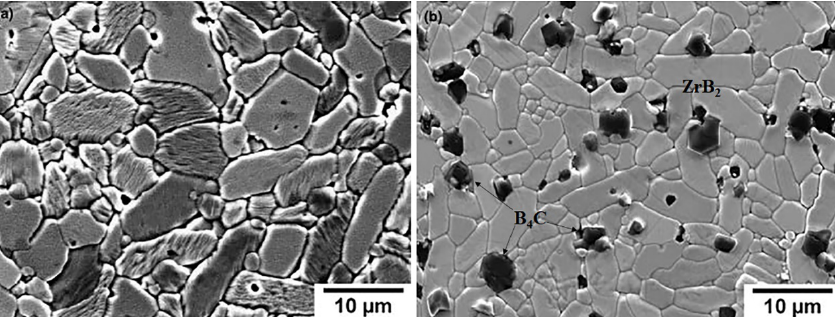
Fig. 3 Microstructures of pressureless sintered ZrB 2 with B 4 C addition at 1850 ℃ /1 h in vacuum: 2 wt% B 4 C (a) and 4 wt%B 4 C additions (b). Reproduced with permission from Ref. [86], © The American Ceramic Society